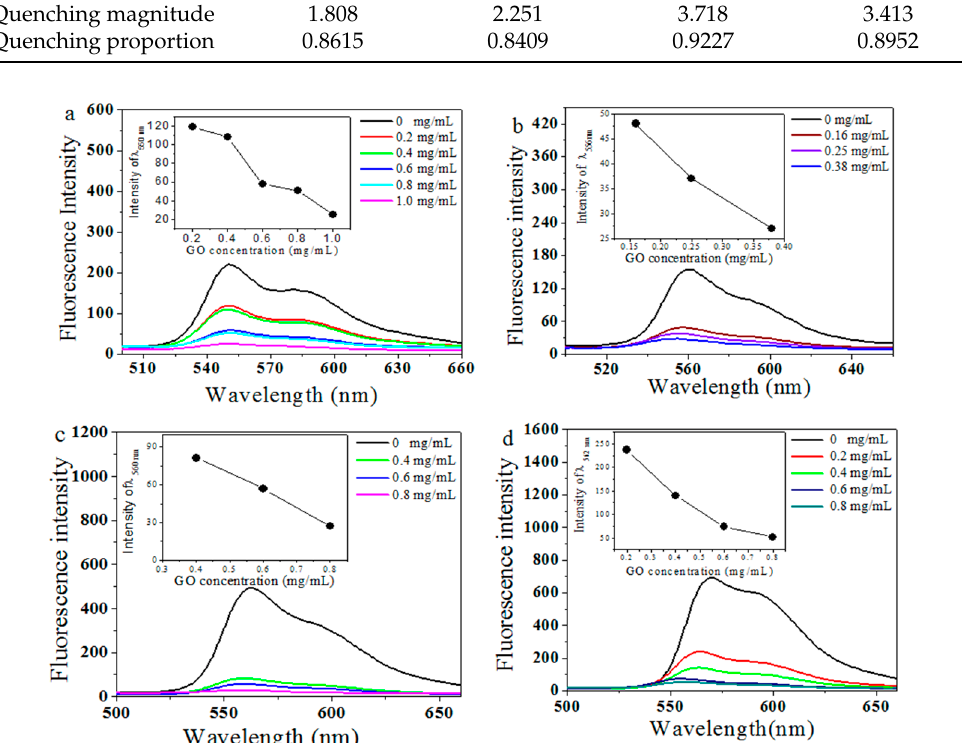
Figure 2. Fluorescence spectra of dyes (10 − 5 mol/L) with different GO concentrations; SBrPDI ( a ); DBrPDI ( b ); SFPDI ( c ); DFPDI ( d ) in N , N- dimethylformamide. Insert: the linear relationship of the corresponding dye fluorescence and GO concentration (mg/mL) (excited wavelength: 525 nm).